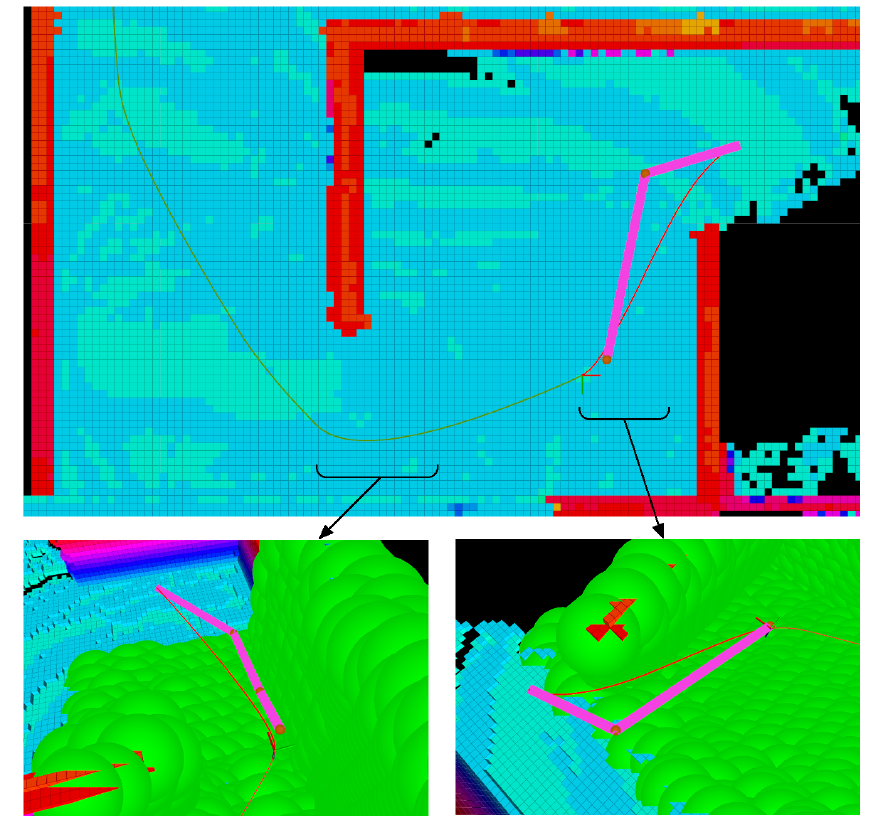
Figure 11. Illustration of trajectory generation and tracking. The green path is the trajectory of the vehicle, and the red path is the future reference path.